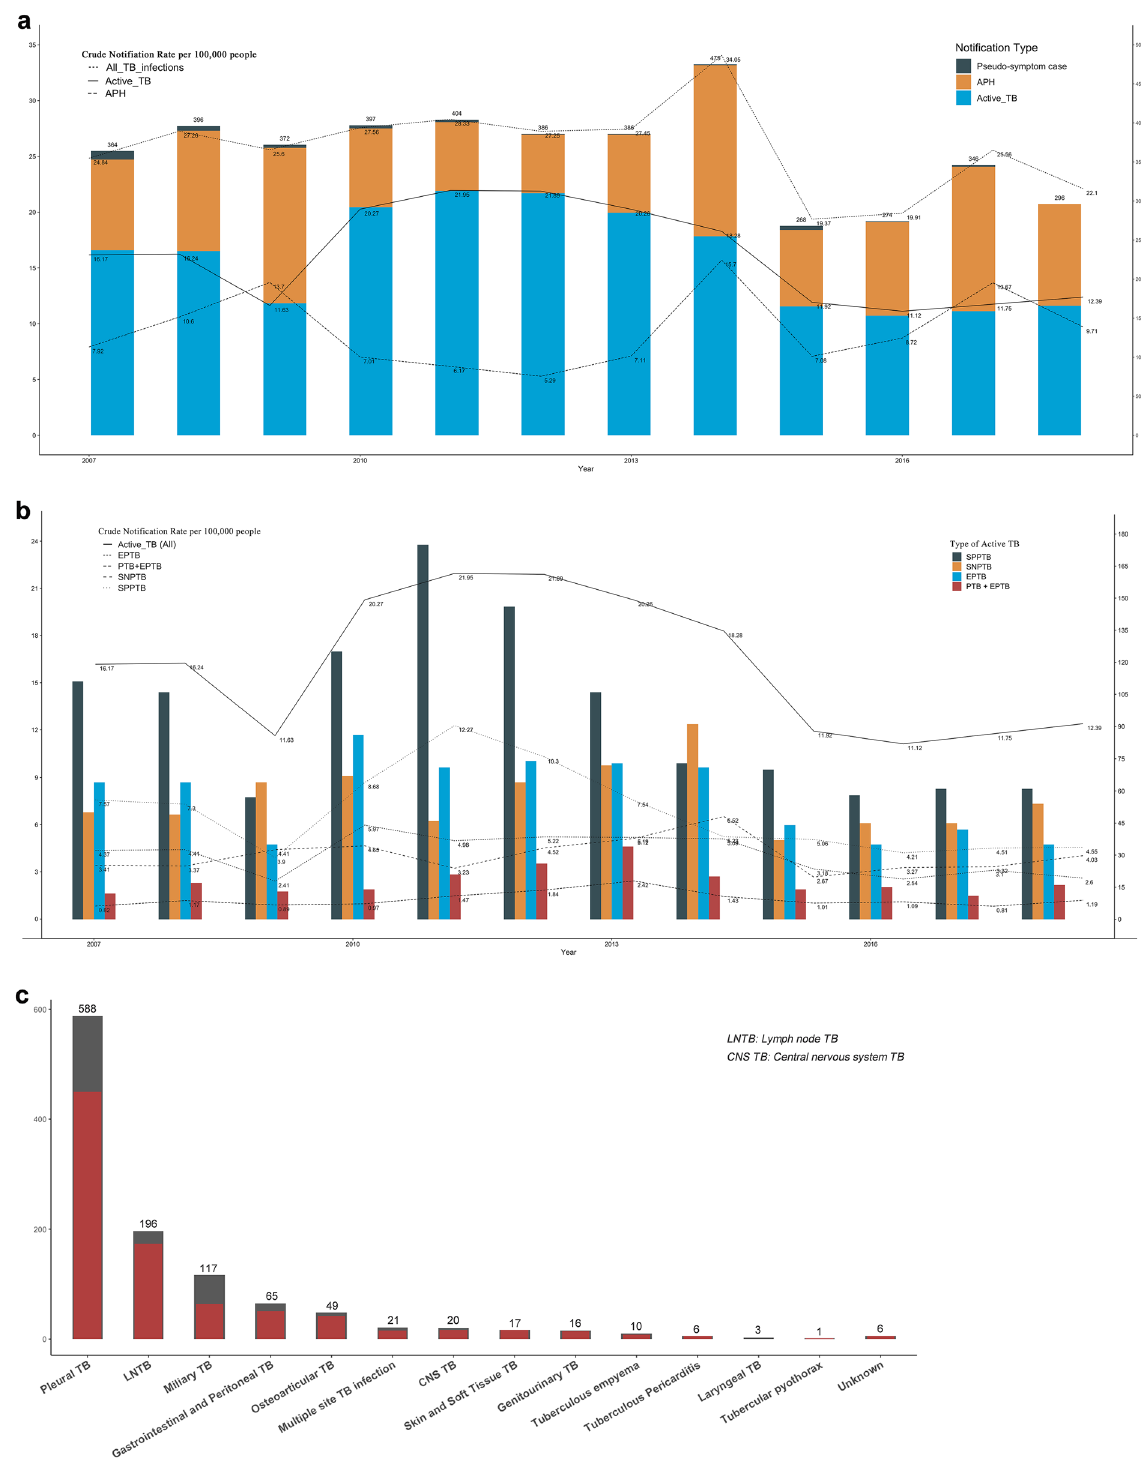
Figure 2. Annual accumulated number and crude notification rate per 100,000 people of TB infections and active TB in Nagasaki Prefecture, 2007 to 2018. ( a ) The notification types of TB infections are active TB, APH (asymptomatic pathogen holder) and pseudo-symptom case, distinguish by colors; ( b ) The types of active TB are SPPTB (smear-positive PTB), SNPTB (smear-negative PTB), EPTB (extrapulmonary TB) and PTB + EPTB, distinguish by colors; ( c ) Accumulated Extrapulmonary Tuberculosis cases in Nagasaki Prefecture, 2007 to 2018. *The black bar graphs represent the number of extrapulmonary TB patients plus those with extrapulmonary TB and pulmonary TB simultaneously; the red bar graphs simply represent the number of extrapulmonary TB